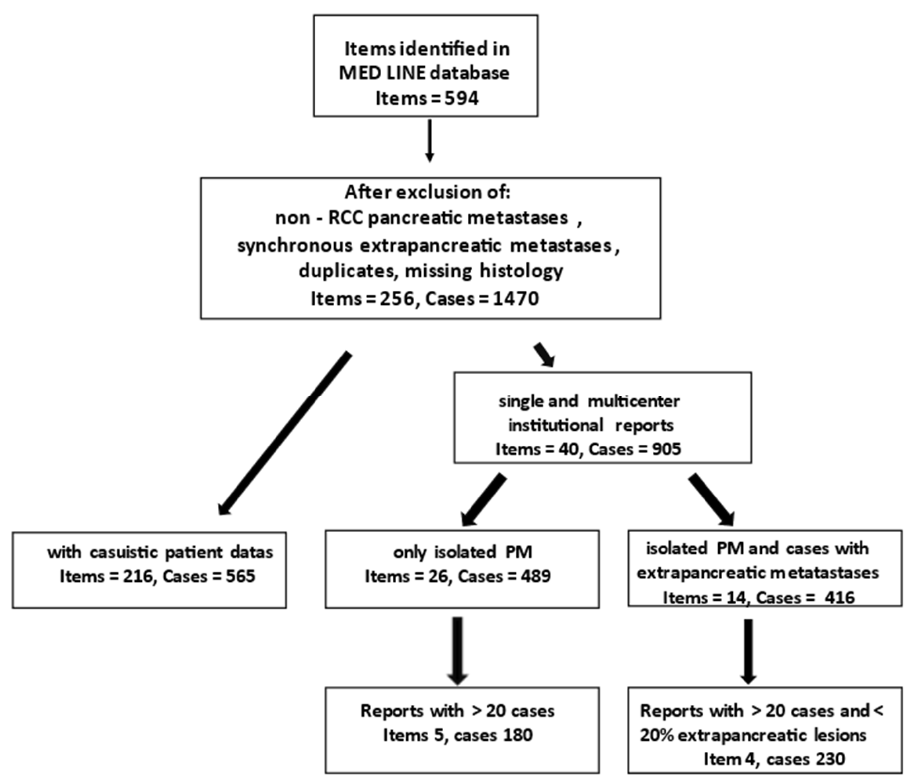
Figure 1. Search and selection strategy.